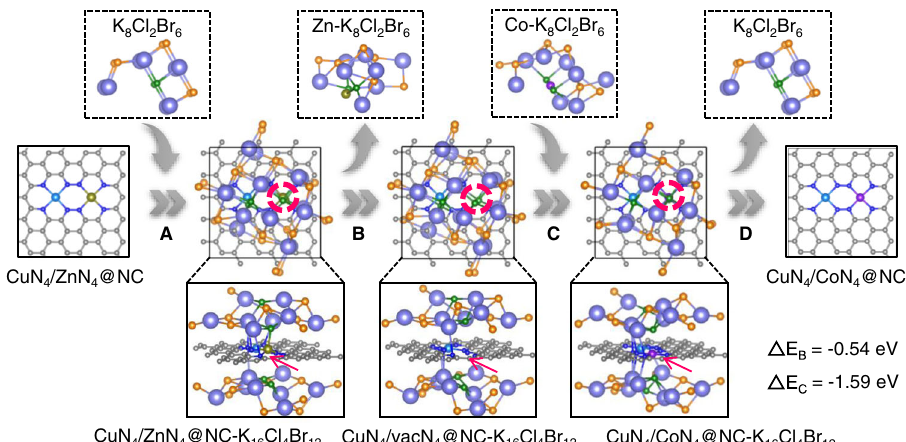
Fig. 3 | Mechanism of the synthesis strategy. Proposed mechanism for the formation of CuN 4 /CoN 4